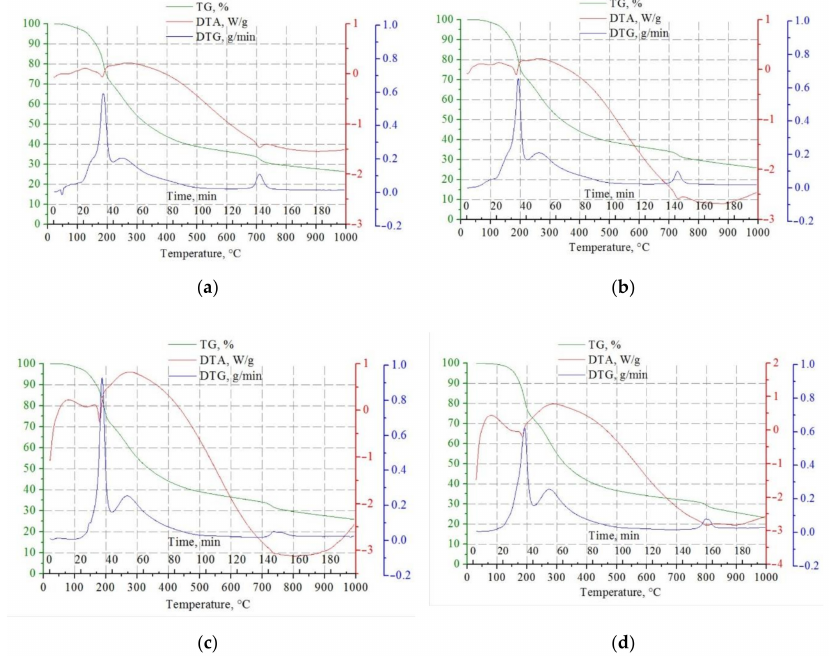
Figure 2. DTA curves of molybdenum-tungsten blue xerogel synthesized with: ( a ) [Mo] / [W] = 95 / 5; ( b ) [Mo] / [W] = 90 / 10; ( c ) [Mo] / [W] = 80 / 20; ( d ) [Mo] / [W] = 50 / 50. (molar ratio [R] / [ Σ Me] = 5.0, inert atmosphere).